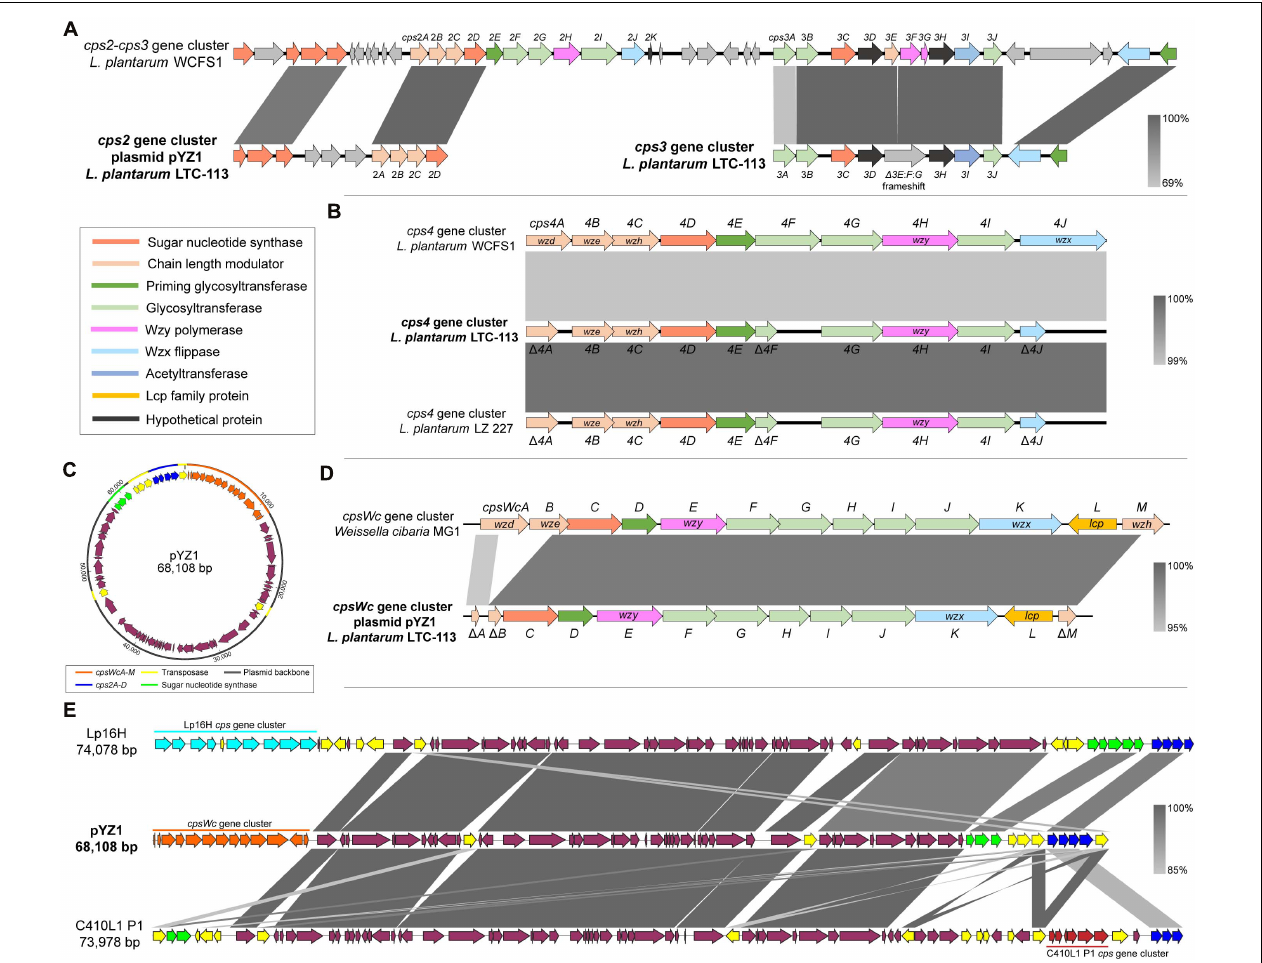
FIGURE 1 | Comparative genomics of cps gene cluster in L. plantarum LTC-113. (A) Schematic representation of the cps2 and cps3 gene cluster of L. plantarum LTC-113 compared to these in L. plantarum WCFS1. Genes were showed as arrows in different colors. (B) comparative analyses of the cps4 gene cluster of LTC-113 compared with that in WCFS1 and LZ 227. (C) The circular map of the plasmid pYZ1. (D) Sequence alignment between the cpsWc gene cluster on pYZ1 and that on W. cibaria MG1. (E) Multiple sequence alignment of plasmids, pYZ1, Lp16H, and C410L1